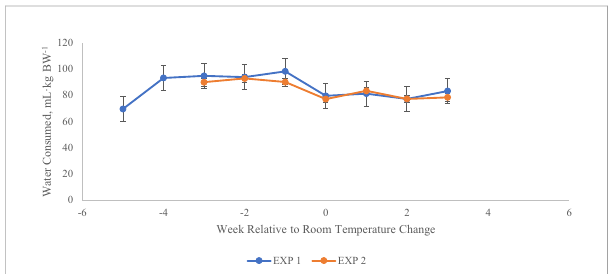
FIGURE 6 Water intake (mL·kg BW -1 ) relative to changes in ambient conditions for heifers in each of two experiments. Weekly water intake has been centered around the date that THI was returned to thermoneutral conditions in each experiment (week 0). The shaded portion of the chart indicates the time period of elevated THI. Consumption was calculated as mL·kg BW -1 , and natural log transformed to meet the assumptions of ANOVA. Untransformed means are shown here. Week -5 of Exp 1 was part of the baseline period, in which all heifers (n = 12) were fed E- seed in daily rations, and room temperature remained at thermoneutral conditions (22.2° C). Also in Exp 1, week -4 included the application of heat stress (33.3°C during day, 22.2°C at night) without consumption of endophytic alkaloids. Treatment effects on water intake are shown in Tables 4 (Exp 1) and 9 (Exp